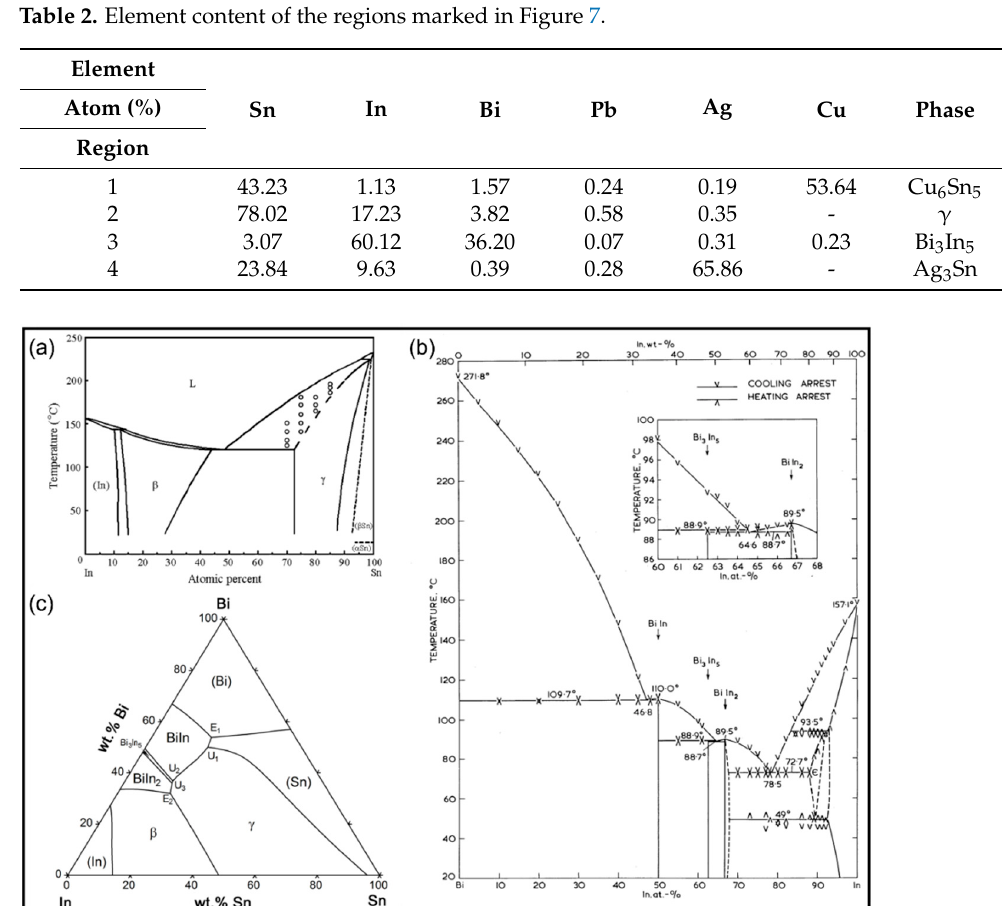
Figure 9. ( a ) The Sn-In phase diagram [28]; ( b ) the Bi-In phase diagram [29]; ( c ) the Bi-In-Sn phase diagram [30].